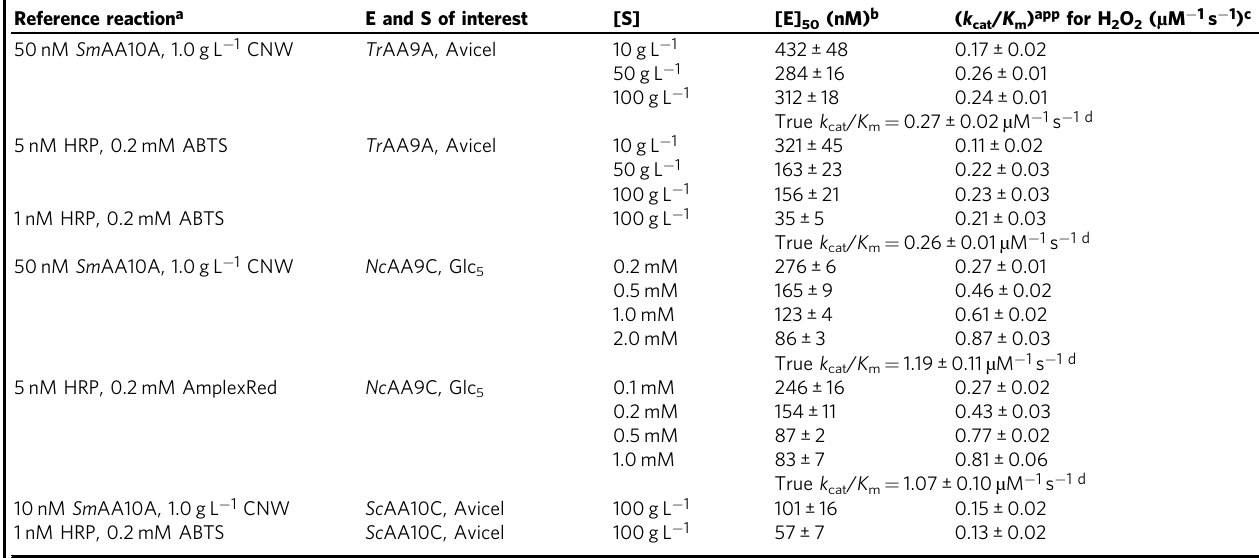
Table 1 Kinetic parameters of cellulose-active LPMOs measured using different reference reactions. Reference reaction a